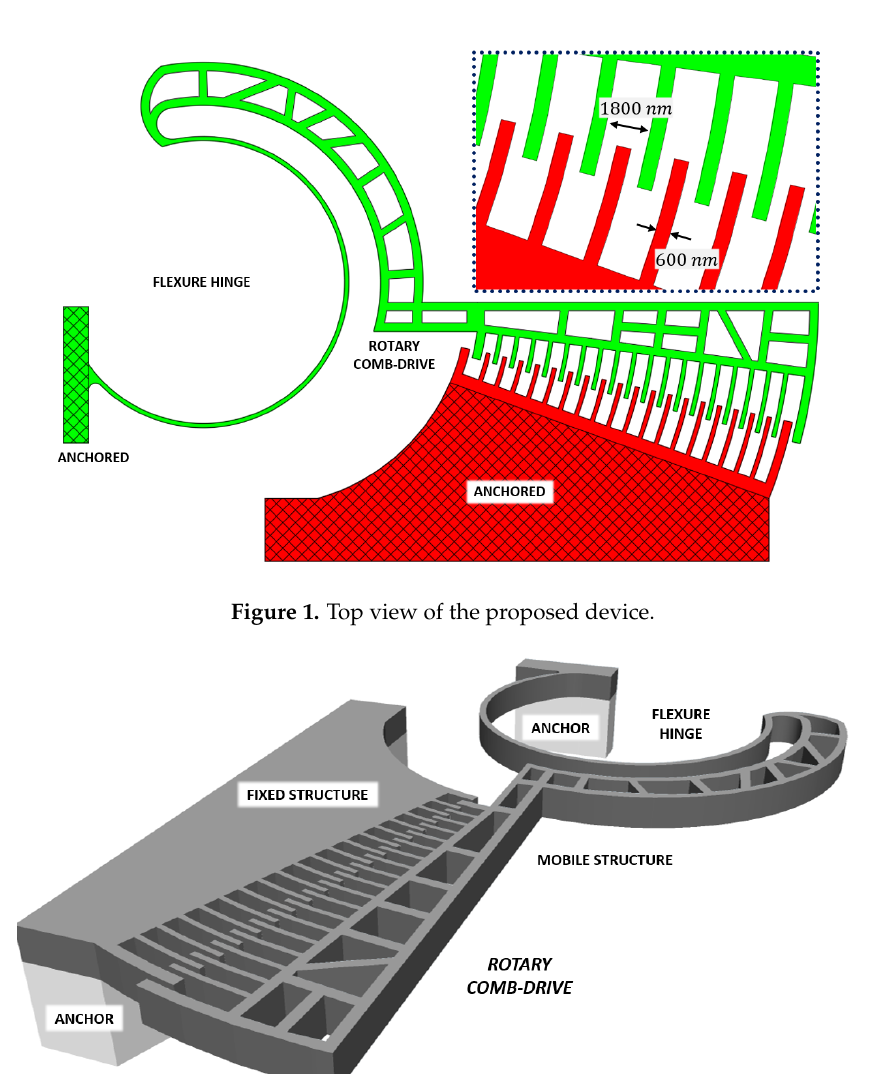
Figure 2. Three-D sketch of the proposed